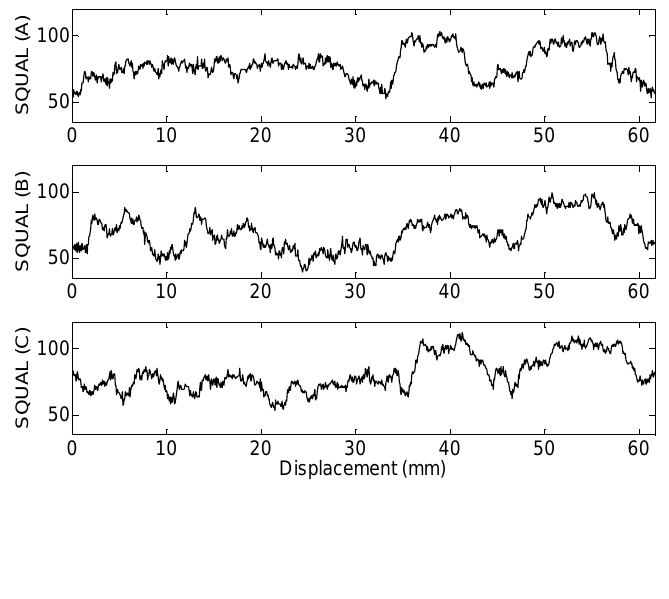
Figure 8. Dynamic evolutions of the values of the SQUAL register in a complete revolution of three different two-Euro